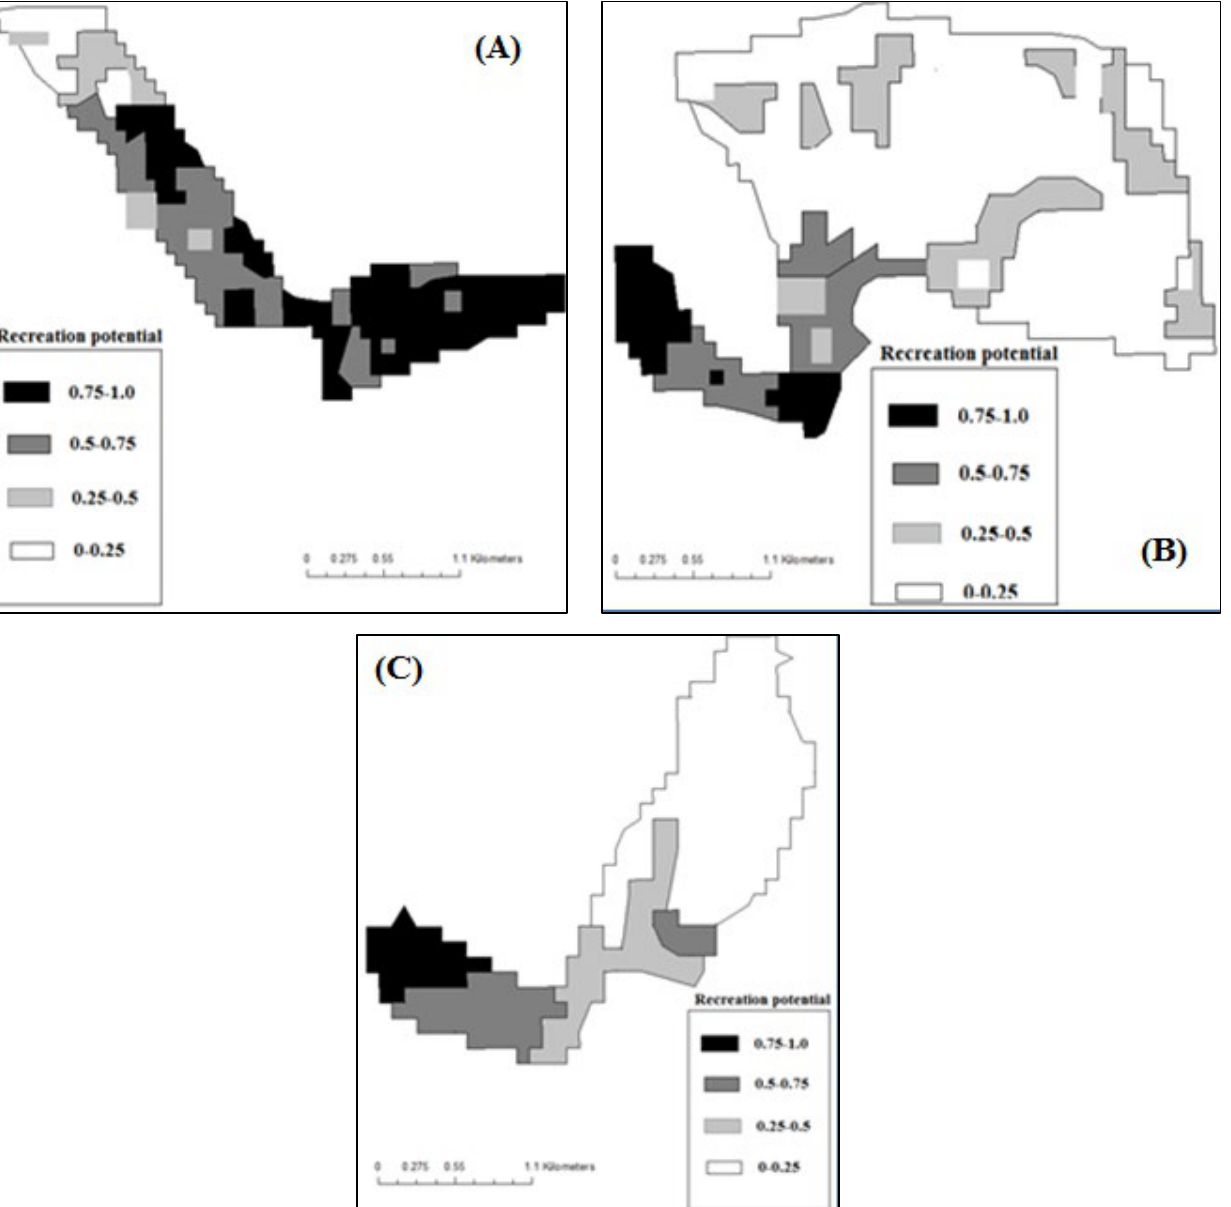
Figure 7. Recreation potential calculated with landscape indicators: ( A ) Shokrabad region; ( B ) Dolatabad region; ( C ) Fakhrabad region. Recreation potential is expressed on a 0–1 scale, where 0 is no recreation potential and 1 is maximum recreation potential.